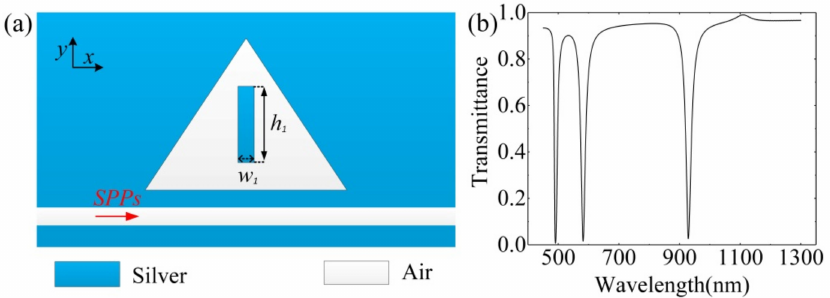
Figure 5. ( a ) The schematic of the ETSC with a bar; ( b ) the transmittance spectrum of the ETSC with a